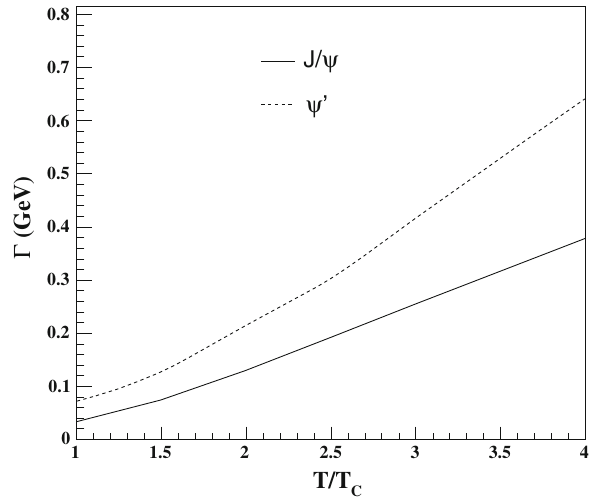
Fig. 13 Variation of decay width ( (cid:8) ) with respect to T / T C . Solid and dash-dotted curves represent the decay width of J /ψ and ψ (cid:8) , respec- tively